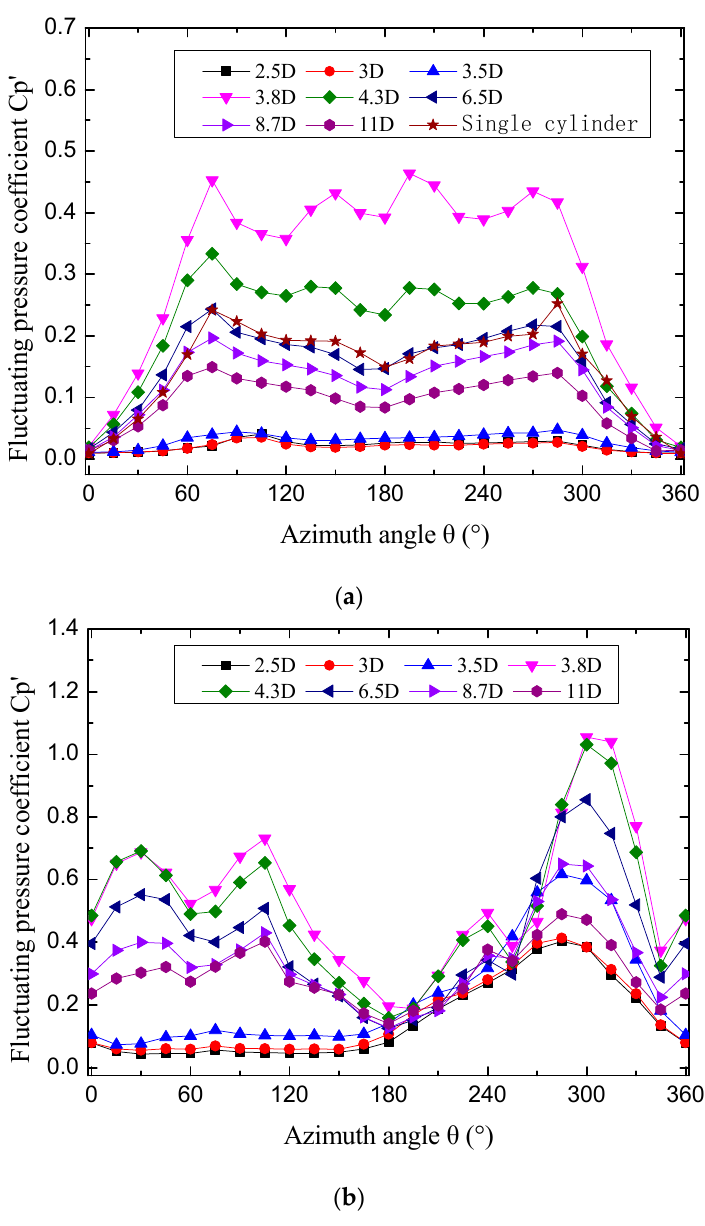
Figure 7. Distributions of fluctuating pressure coefficients on cylinders at α = 9°: ( a ) upstream cylinder; ( b ) downstream cylinder.